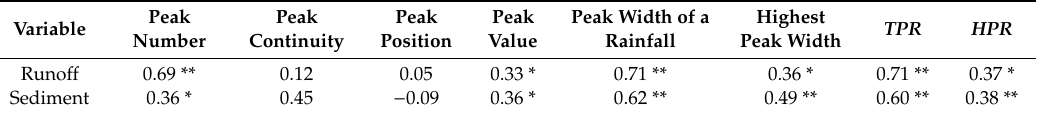
Table 3. Correlation table between morphological indexes of rain peak with runo ff and sediment yield. Variable